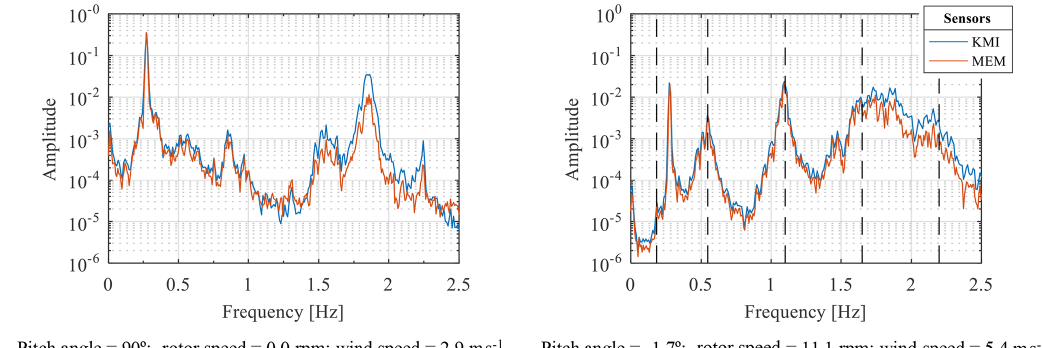
Figure 9. Power spectra from force balance (KMI) and MEM sensors (1 (cid:127) , 3 (cid:127) and 6 (cid:127) marked with dashed vertical lines).